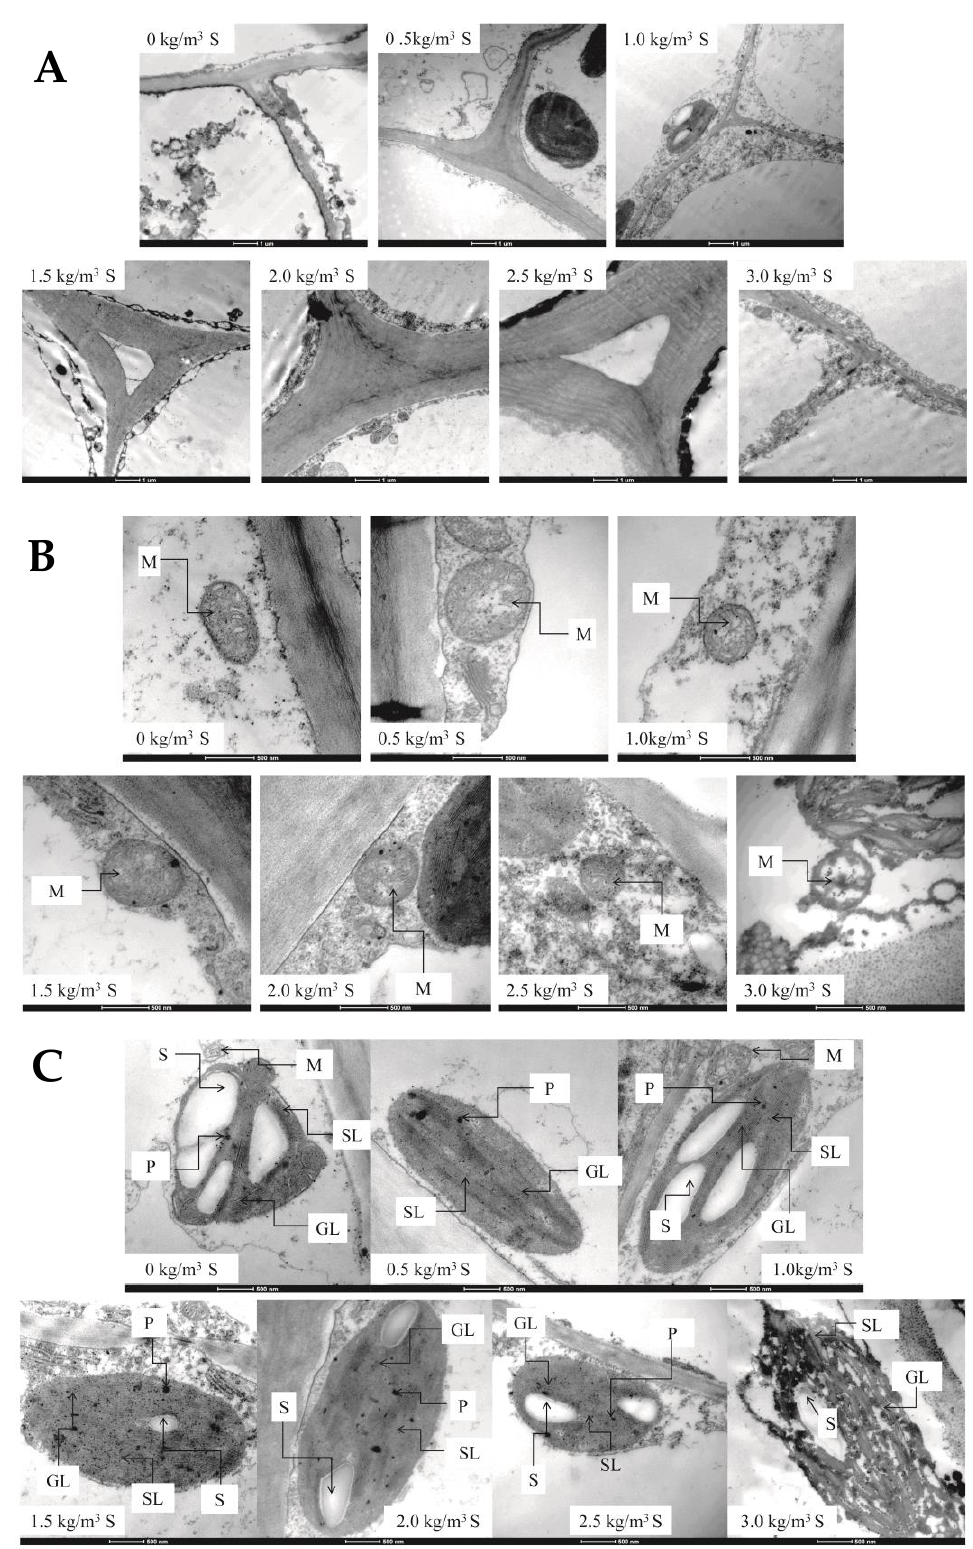
Figure 3. The effect of sulfur content on the ultrastructural morphology of kiwifruit stems where letters represent cyto- derm ( A ) chloroplast (( B ) M. mitochondrion; S. starch; GL. granum lamella; SL. stroma lamella; P. plastoglobulis.) and mitochondria (( C ) M: